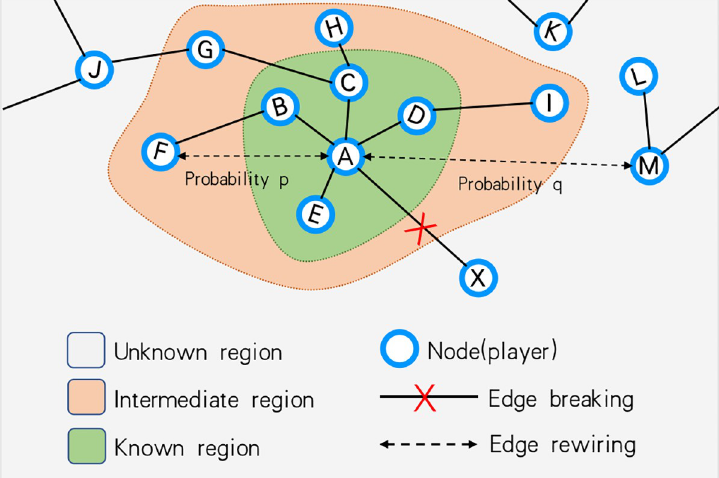
Fig 3. Example of rewiring of partner switching. Node A disconnects the edge of node X . Node A is allowed to divide other nodes into three regions. The immediate neighbors are the known region (nodes A-D ), shown in green. Node A has played with players in the known region and has given them a trust score. The second-order neighbors that are not directly connected ( F-I ), shown in orange, make up the intermediate region. Other nodes ( J-M ) belong to the unknown region and are shown in gray. The probability of the node selecting a new partner in intermediate region is p , and the probability of selecting a partner in the unknown region is q = 1- p . p is a function of the average trust score of the known region.